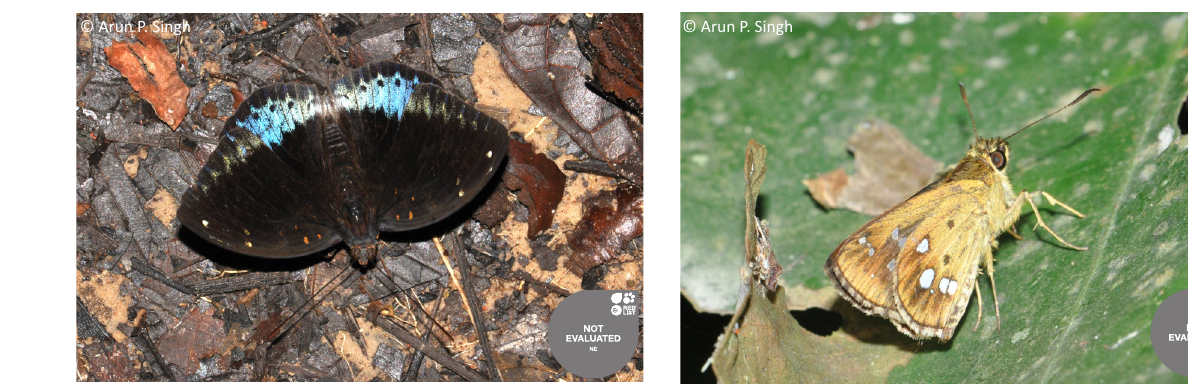
Image 5. Brown Forest Bob Scobura woolletti